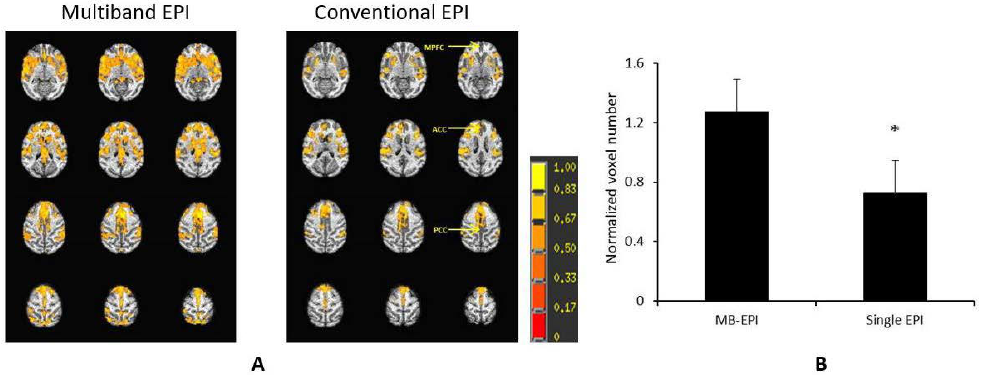
Figure 1. Demonstration of the multiband MRI technique to improve detection sensitivity of BOLD signal in anesthetized monkeys on a Siemens TIM Trio 3T scanner with an 8-channel array volume coil. ( A ) Normalized correlation maps of the default mode network (DMN) of anesthetized (1% isoflurane) rhesus monkeys scanned by using the multiband echo planar imaging (multiband EPI) sequence with the parameters: TR = 1059 ms/TE = 25 ms, MB factor = 4, voxel size=1.5 mm × 1.5 mm × 1.5 mm, time of acquisition = 10 min), and conventional single-shot EPI acquisition (conventional EPI) with TR = 2190 ms/TE=25 ms, voxel size=1.5 mm × 1.5 mm × 1.5 mm, time of acquisition = 10 min. The z-score threshold: p < 8 × 10 −18 plus cluster threshold 169 mm 3 /overall, mean ± stdev. n = 4. *: p = 0.08, paired t -test. ( B ) Comparison of normalized voxel numbers (normalized by average voxel numbers across DMN from the two EPI acquisitions (multiband EPI vs. single EPI). MB, multiband.